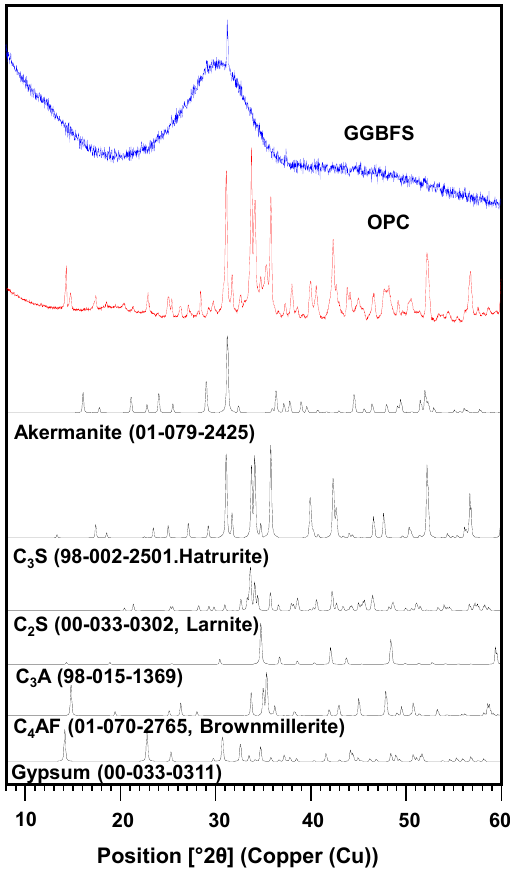
Figure 2. XRD patterns of OPC and GGBFS with identified phases.